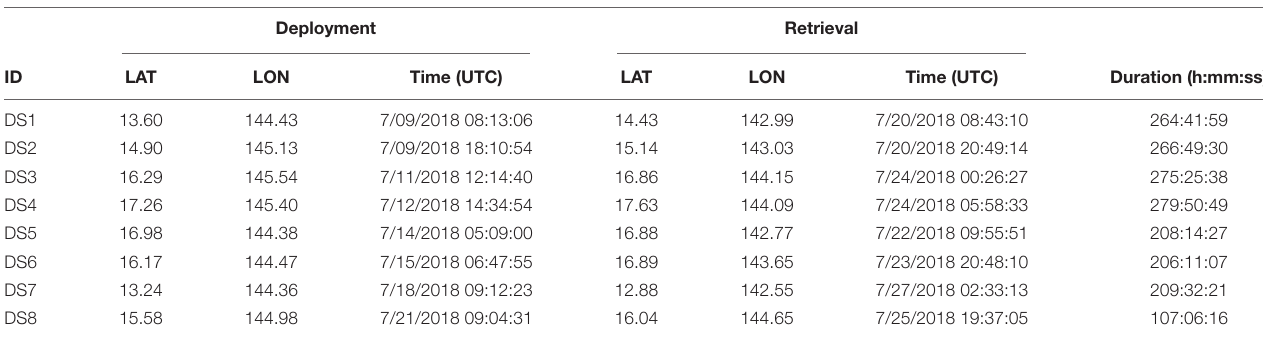
TABLE 1 | DASBR deployment and retrieval locations. Deployment